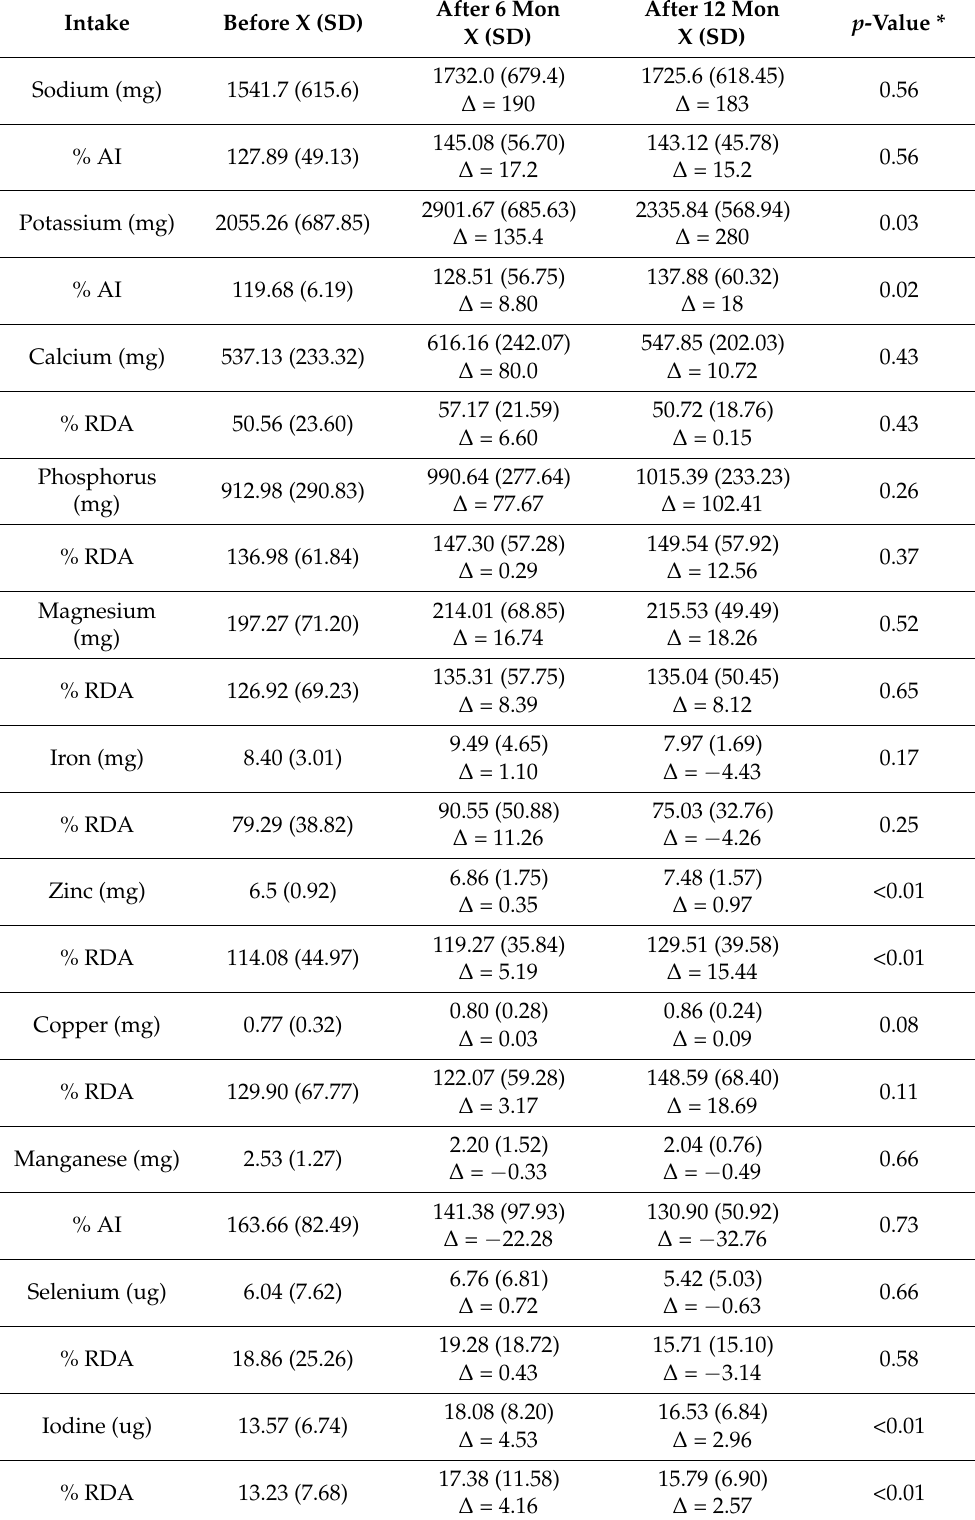
Table 4. Daily dietary intake and norm implementation of micronutrients in the studied